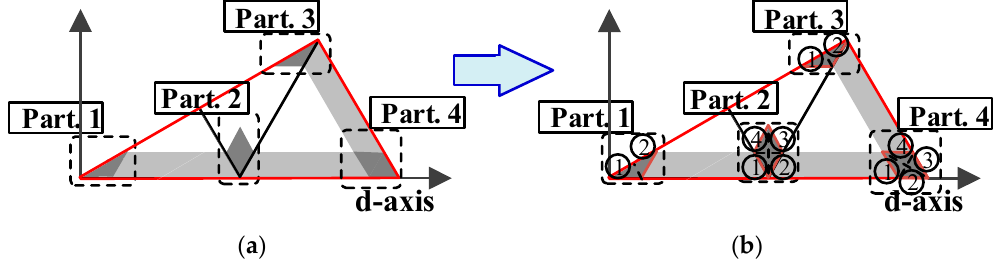
Figure 18. Detailed view of the parts of the positive shifted sector 0. ( a ) Part1–Part4; ( b ) segmentation of Parts.